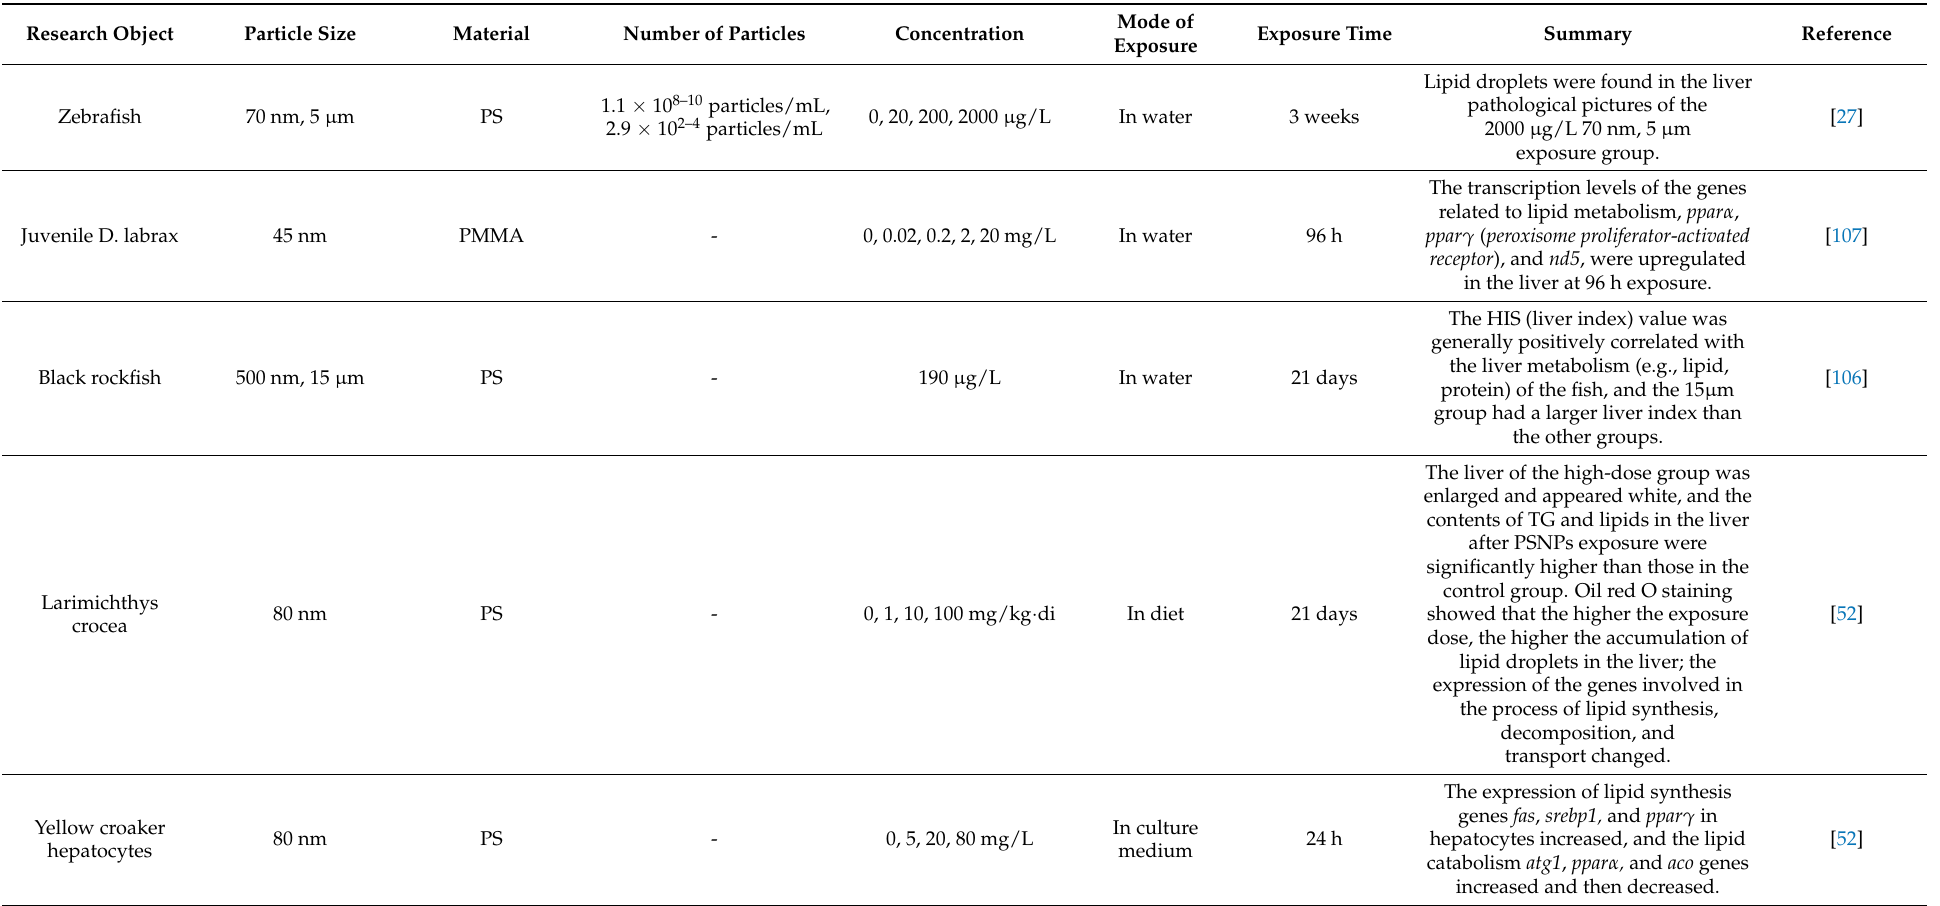
Table 6. The study parameters and effects of MPs and NPs on hepatic lipid